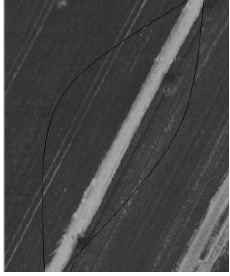
Figure 12: Bezier Curves